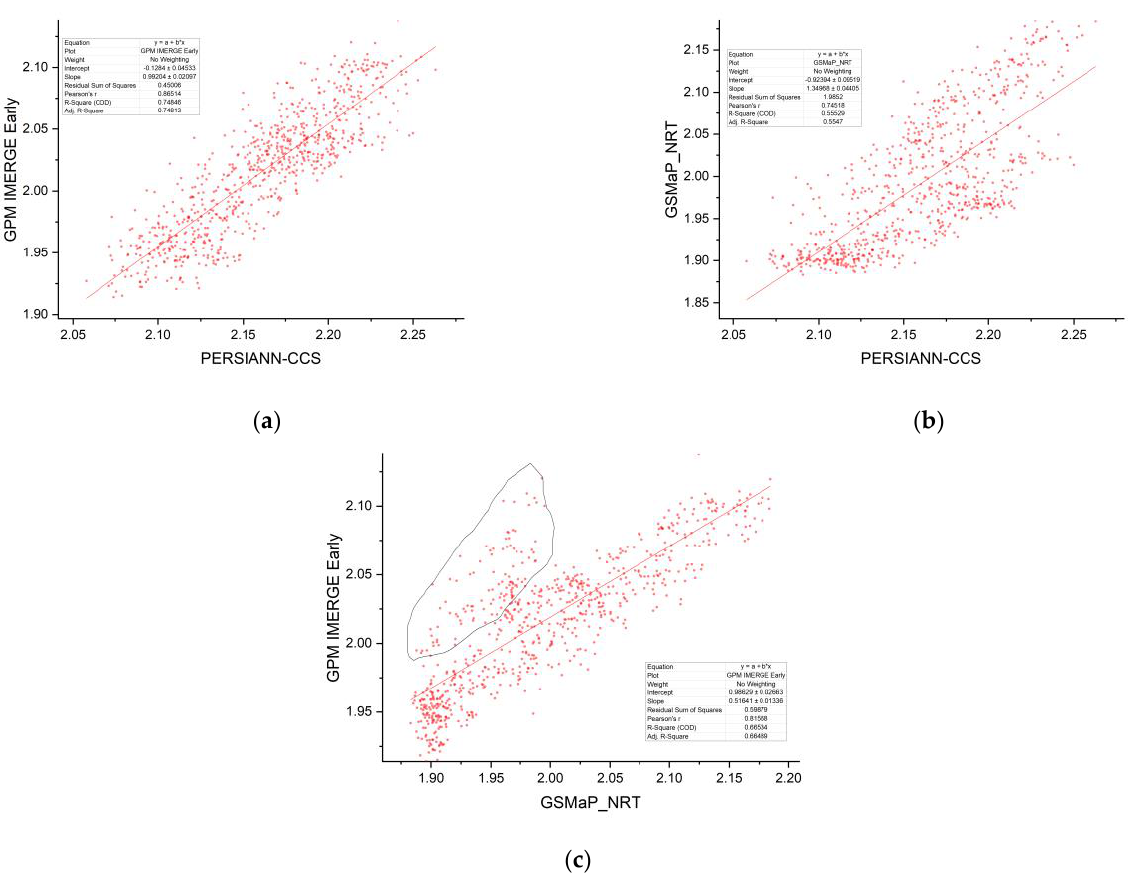
Figure 14. Spatial distribution correlation analysis of information entropies obtained from three sets of satellite precipitation deviation data. ( a ) PERSIANN − CCS and GPM IMERGE Early; ( b ) PERSIANN-CCS and GSMaP_NRT; ( c ) GSMaP_NRT and GPM IMERGE Early.